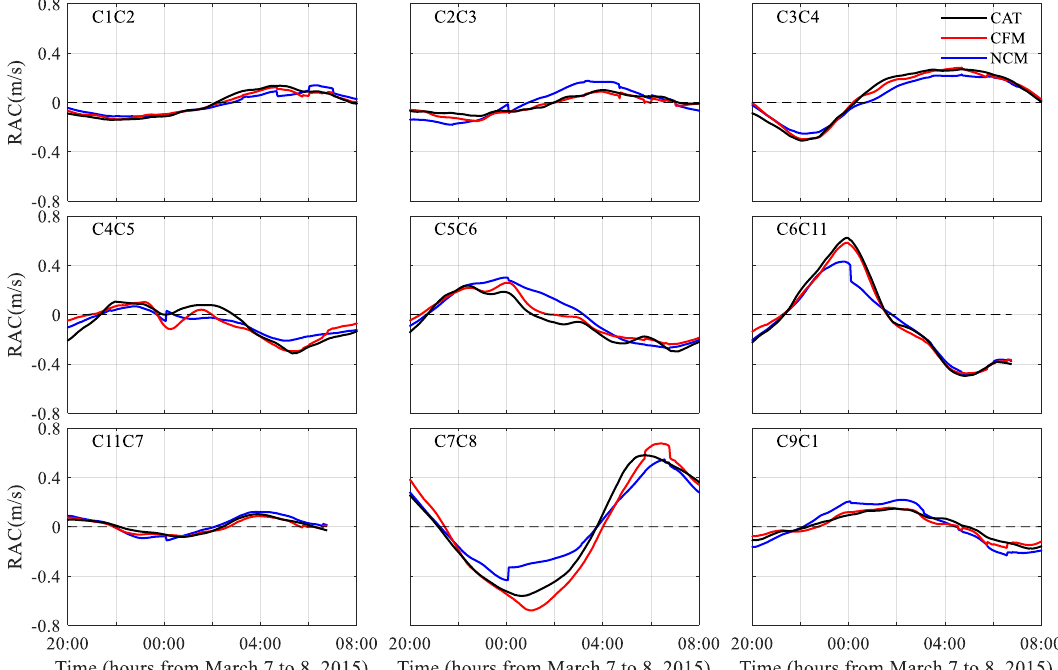
Figure 5. Comparison of RACs that were obtained by coastal acoustic tomography (CAT) observation (black line), coast-fitting method (CFM) (red line), and no coast method (NCM) (blue line) for the nine transmission paths at the periphery of the tomography domain.